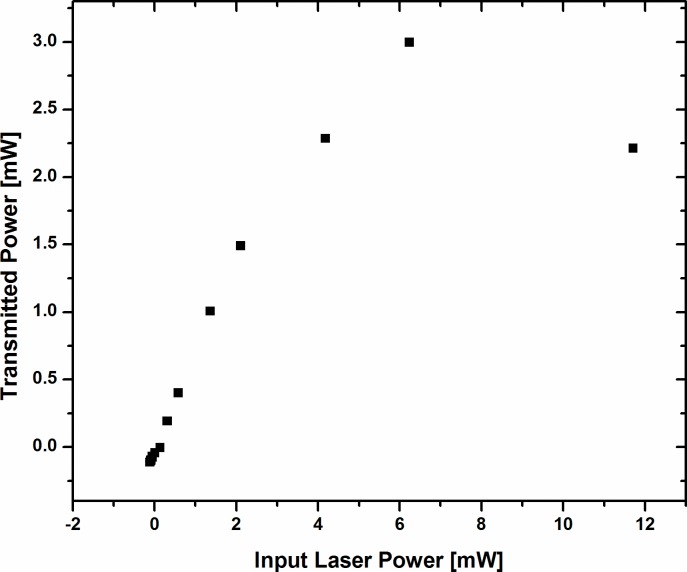
Variation of transmitted power with input laser power of dye A3, recorded at a fixed position (valley point) and at concentration 100x10-5 M.